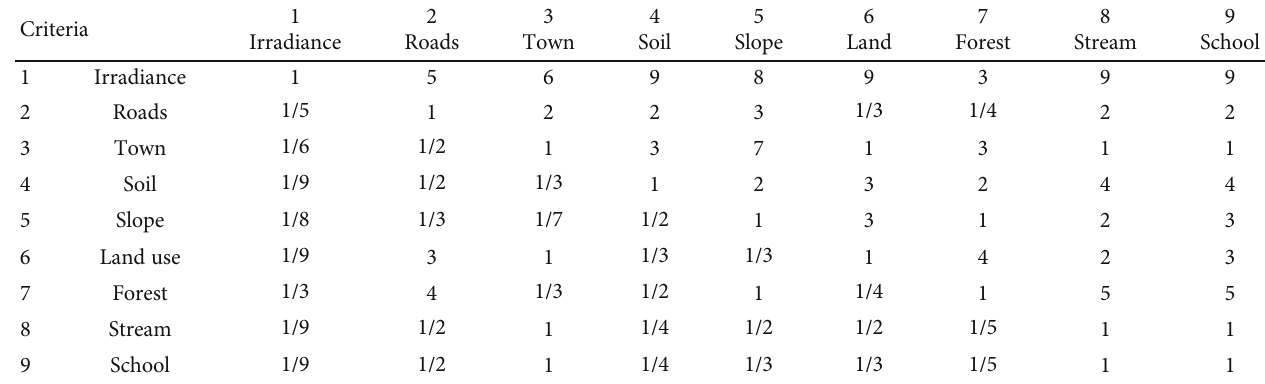
Table 4: Decision-maker matrix of a solar PV power plant.